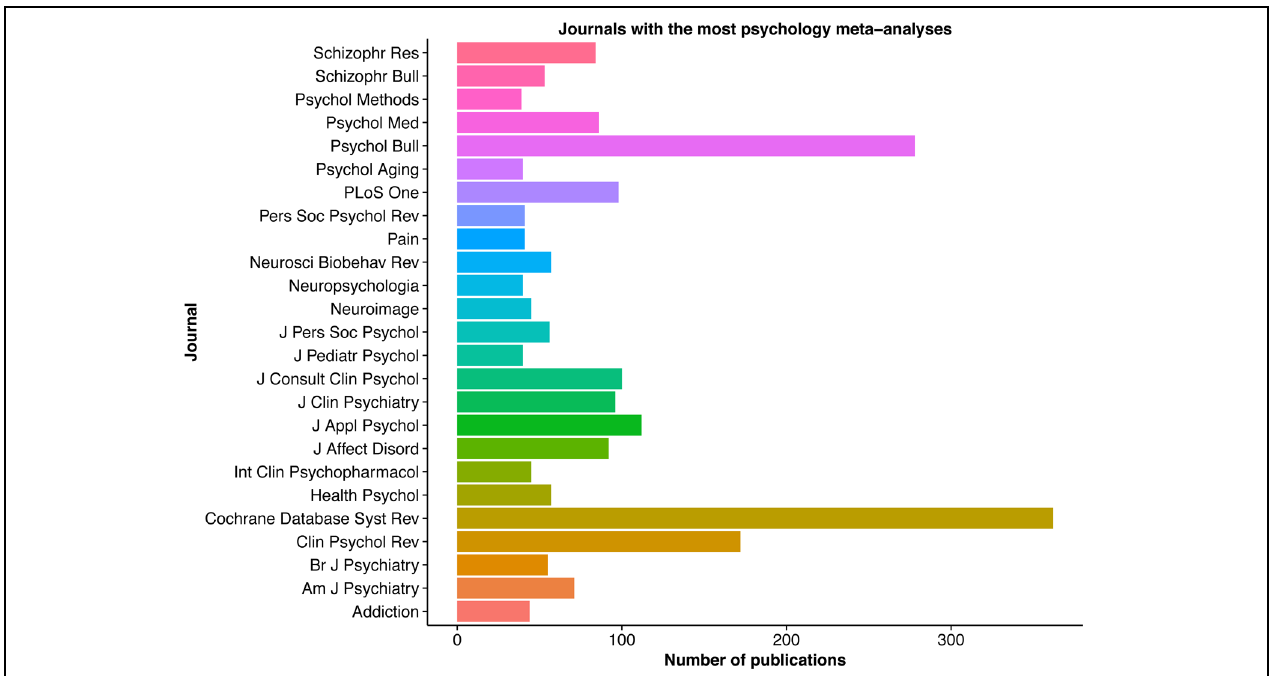
FIGURE 2 | Psychology journals that publish the greatest number of meta-analyses. The number of publications containing the keywords “psychology” and “meta-analysis” for the 25 journals with the most meta-analysis in psychology. Data was collected using the ‘RISmed’ R